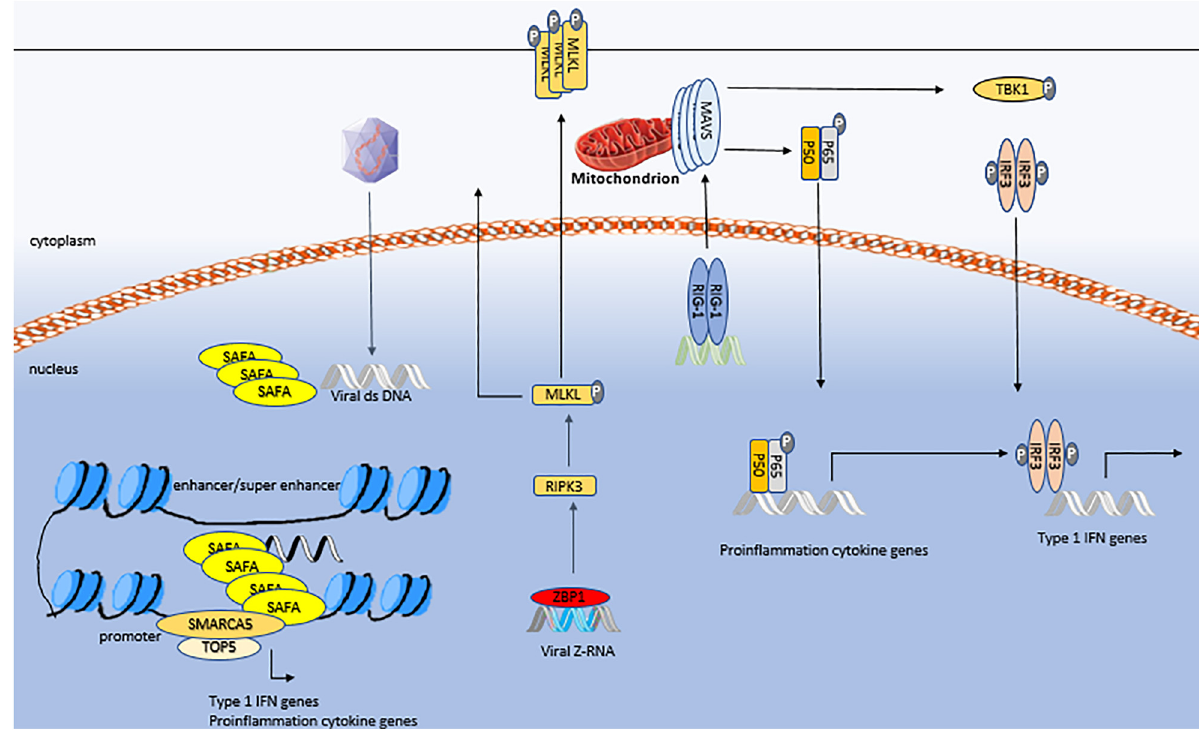
Figure 3: Nucleus RNA sensors such as SAFA, nucleus-localized RIG-I, and ZBP1 act in innate immunity and inflammation. Some nucleus RNA sensors such as SAFA act as a viral dsRNA sensor and trans-activator to initiate the innate immune response and